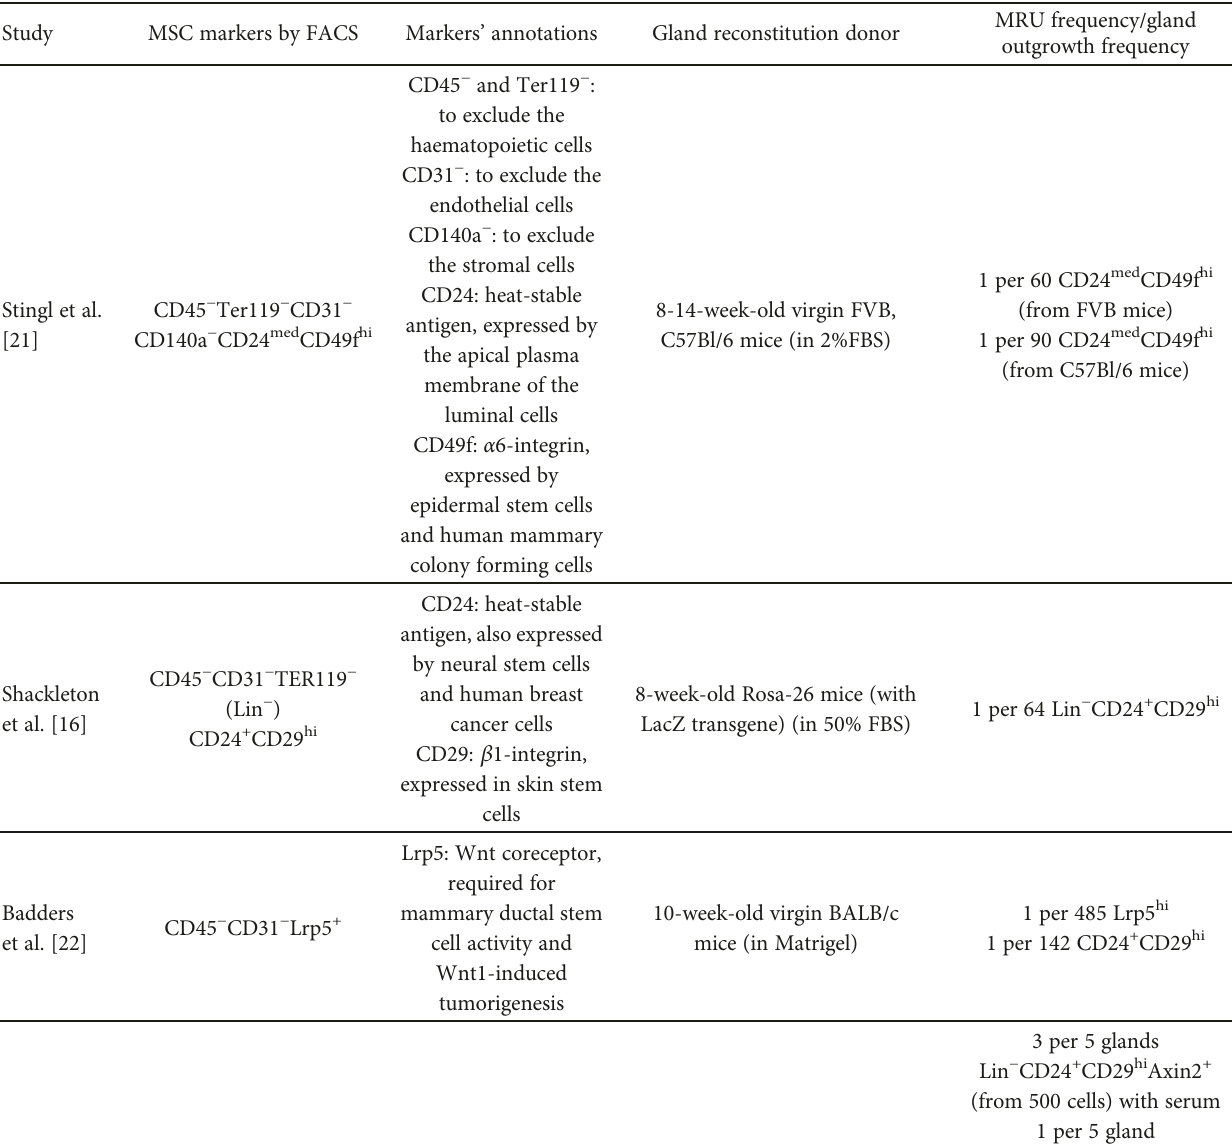
Table 1: Markers used to identify MaSCs in di ff erent